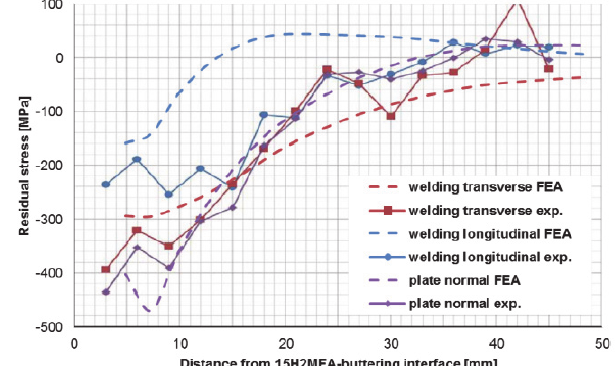
Figure 12: Estimate of residual stresses along a line 23.33 mm from the specimen surface.